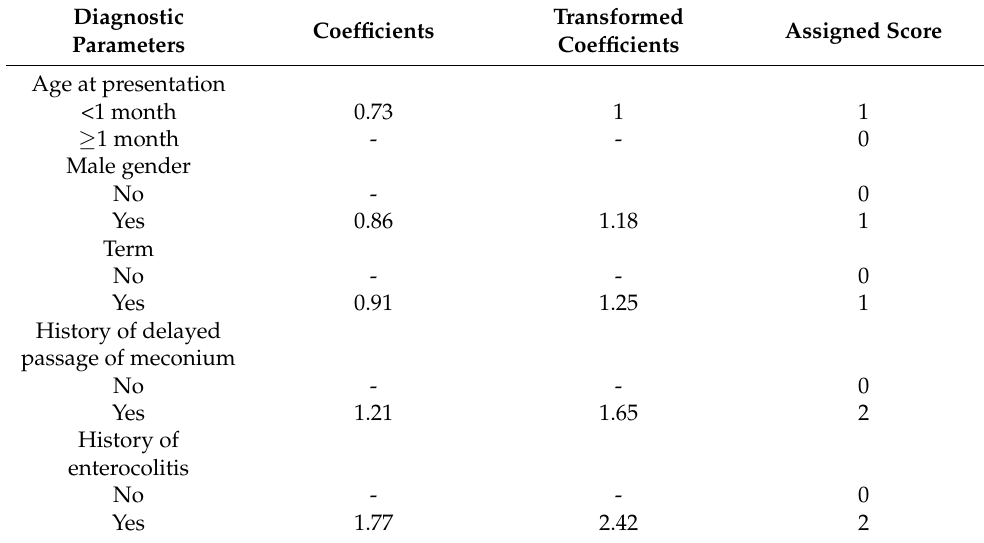
Table 3. Item scoring scheme for diagnostic parameters for HSCR derived from coefficients of select indicators.